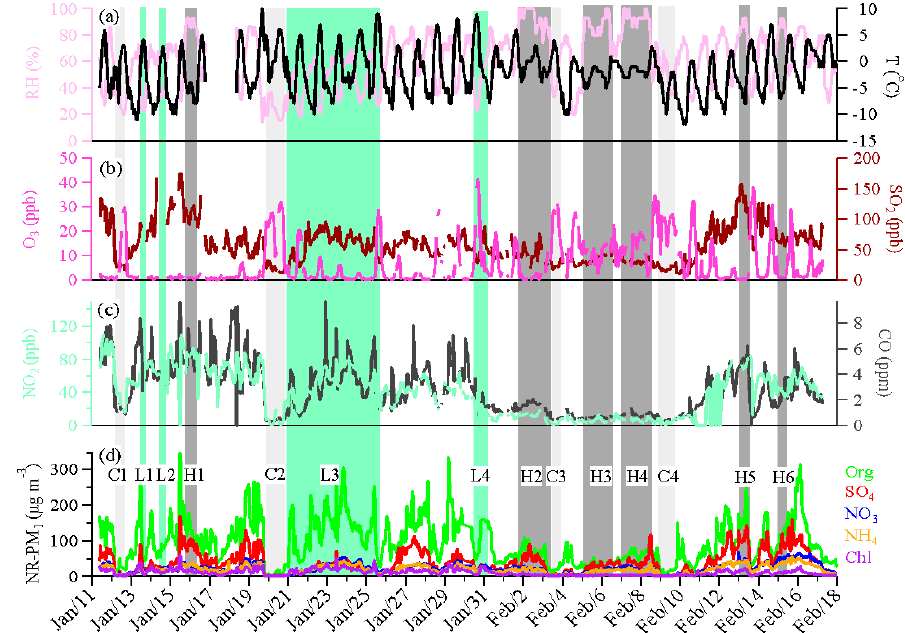
Figure 1. Time series of relative humidity and temperature (a) , O 3 and SO 2 (b) , NO 2 and CO (c) , and the NR-PM 1 species (d) during the observation period. Six high-RH ( > 80%) polluted episodes (H1–H6), four low-RH ( < 60%) polluted episodes (L1–L4), and four clean episodes (C1–C4) are marked for further